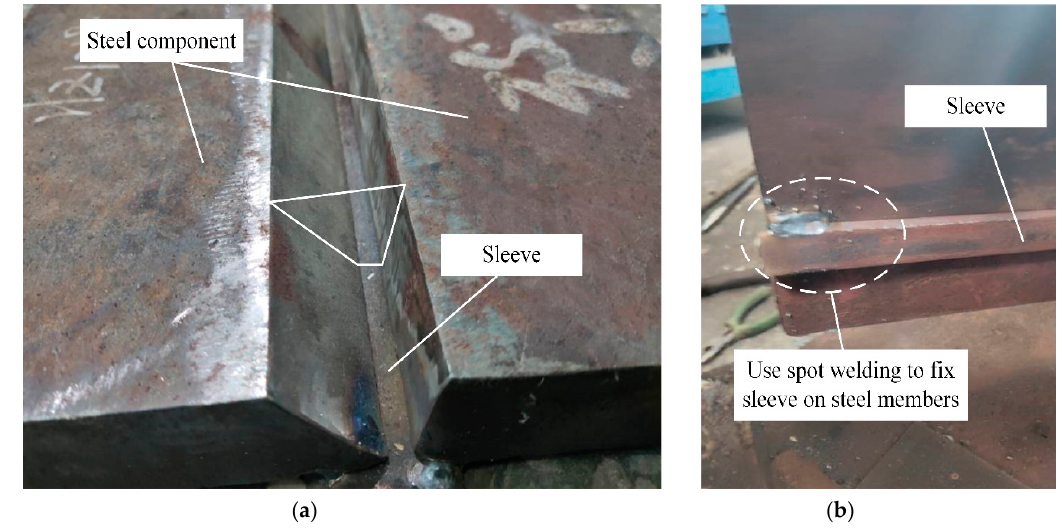
Figure 1. ( a ) Groove structure (The white part is the groove section shape); ( b ) Combination.